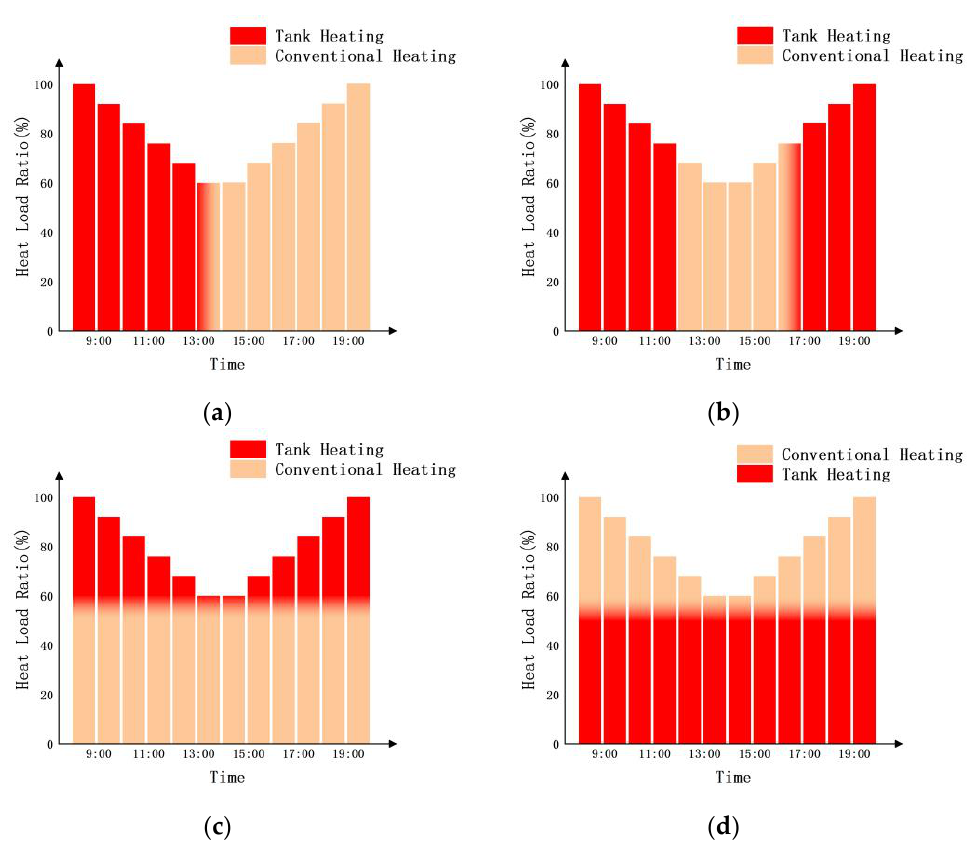
Figure 6. Four operation strategies: ( a ) Case 1; ( b ) Case 2; ( c ) Case 3; ( d ) Case 4.